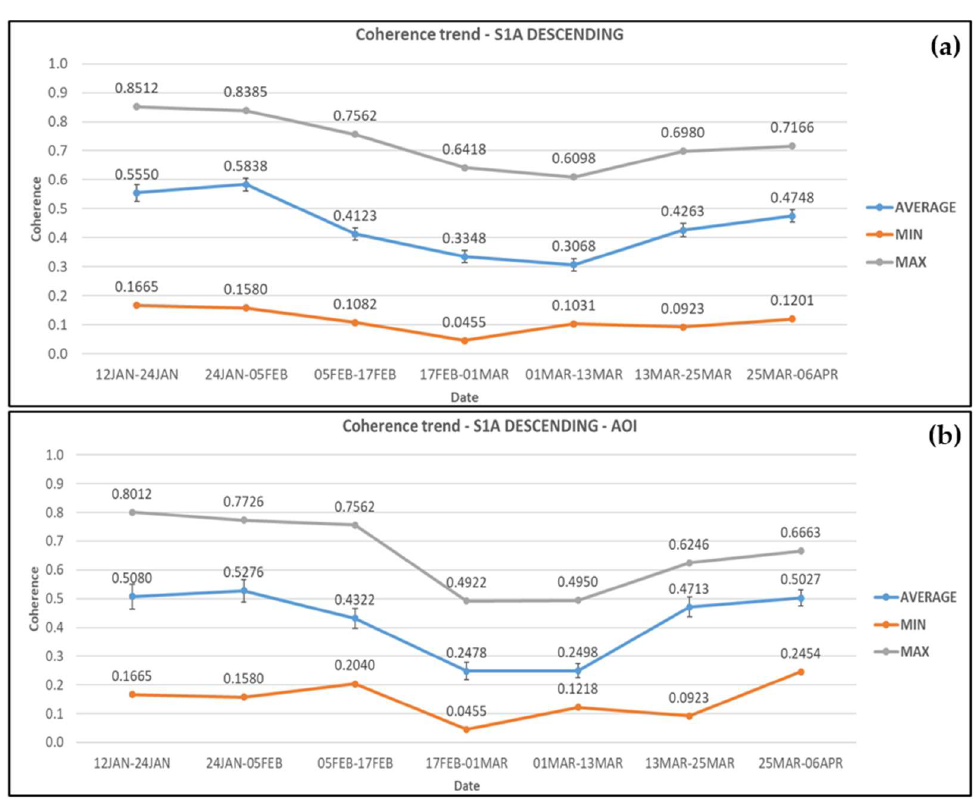
Figure 5. Coherence changes obtained from Sentinel-1A descending satellite images for ( a ) the wider area and ( b ) the AOI. Error bars can be seen in the average coherence values.